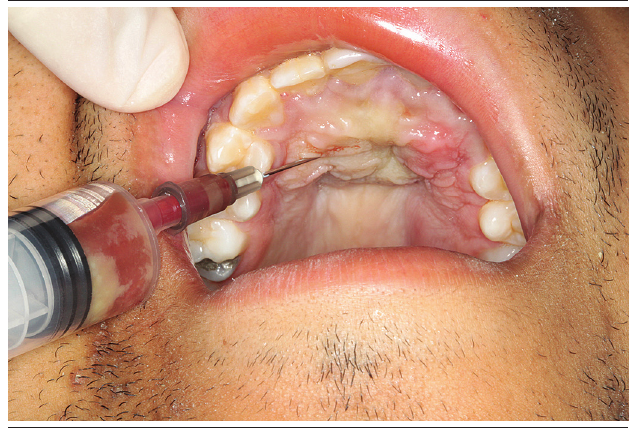
figurE 16 − Swollen anterior hard palate of patient of case 2, 28 days after surgery and purulent bloodstream drainage